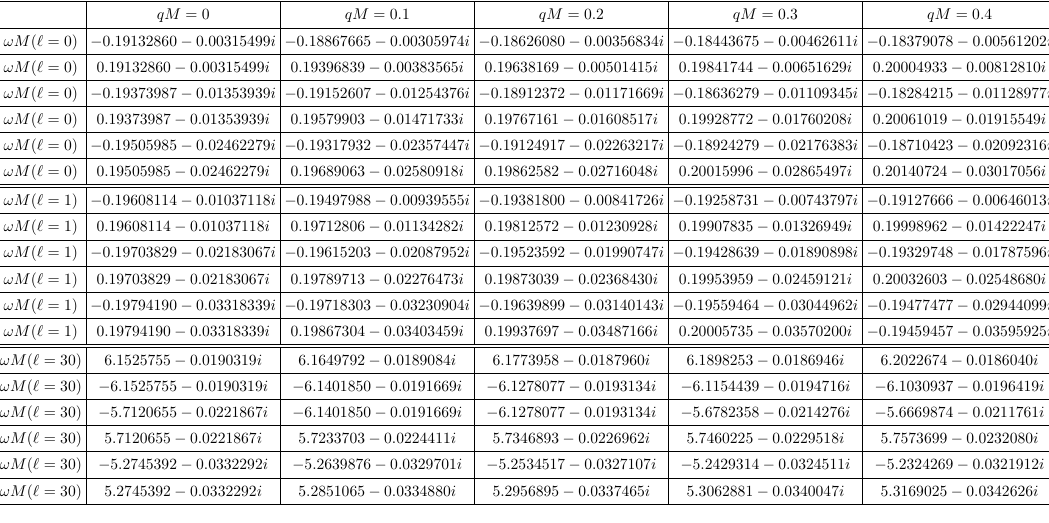
Table 6 . The QNFs ωM for massive ( mM = 0 . 20 ) scalar fields in the background of RNdS black holes with Λ M 2 = 10 − 4 , Q/M = 0 . 50 , and different values of ‘ , and qM .